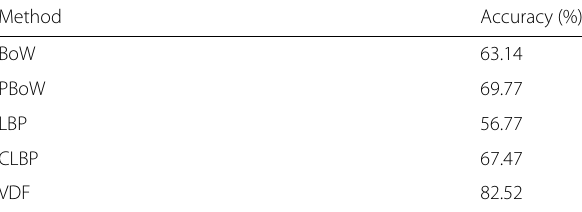
Table 3 Classification accuracy (%) using visual